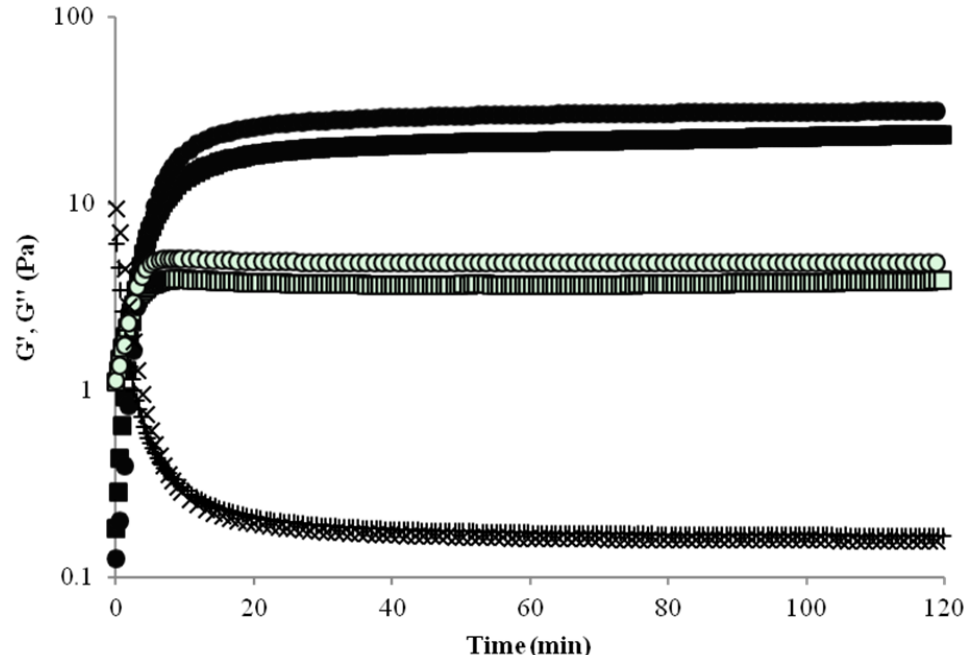
Figure 1. Gelation of 2% ( w/v ) WEAX solution, G' ( ○ ), G'' ( ● ), tan δ (×) and 2% ( w/v ) WEAX solution containing B. longum , G' ( ■ ), G'' ( □ ), tan δ (+). Laccase was used as cross-linking agent. Measurements at 25 °C, 1 Hz and 10%